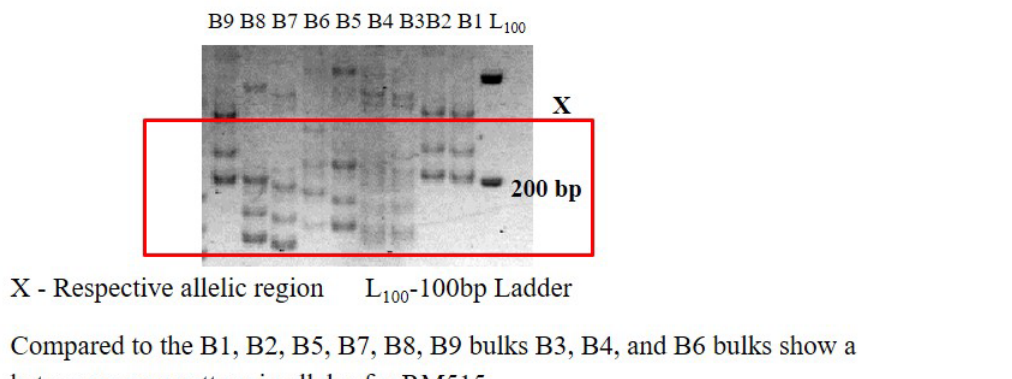
Supplemental Figure 2: PCR profile or heterogenic marker RM515 of DNA